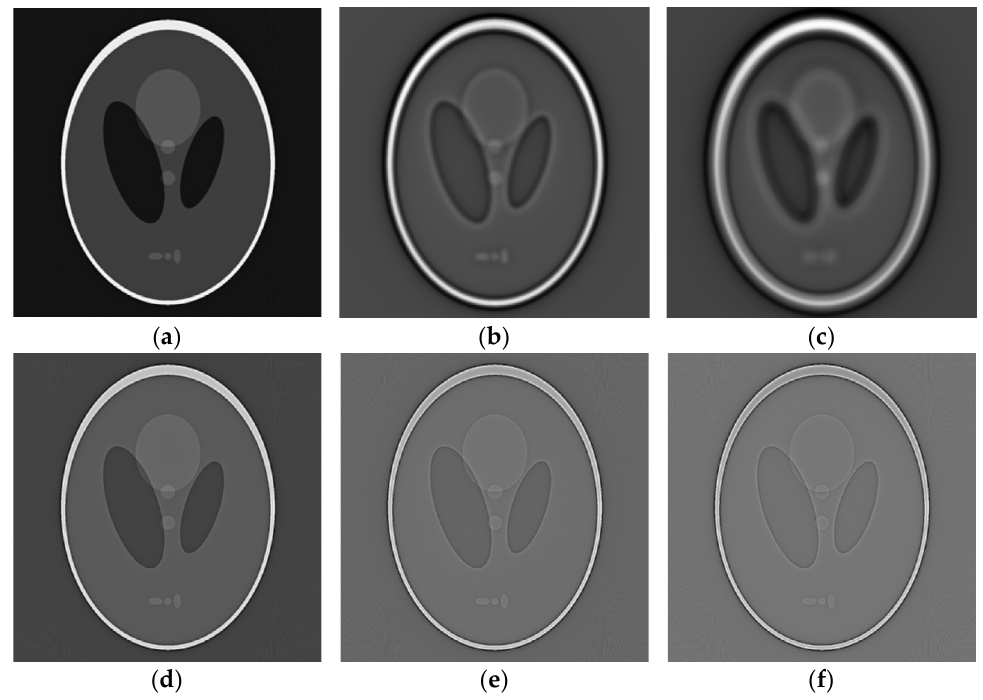
Figure 2. Reconstructed Shepp–Logan phantom images by basic filters with different parameters: ( a ) λ = 1/2; ( b ) λ = 25/2; ( c ) λ = 49/2; ( d ) λ = 3/4; ( e ) λ = 7/8; ( f ) λ = 15/16. .